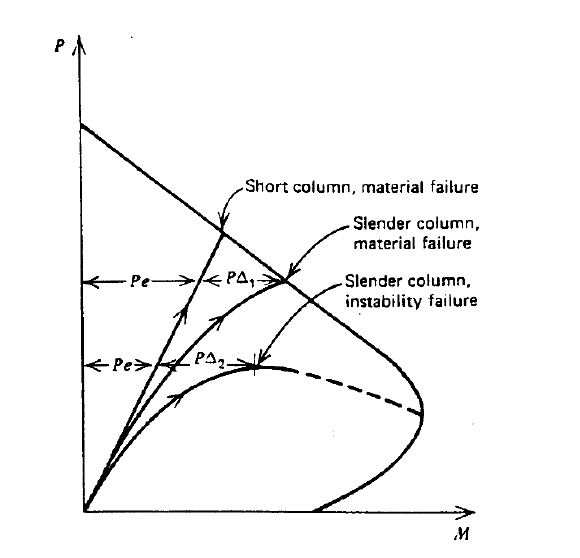
Figure 1. Types of failure for reinforced concrete columns